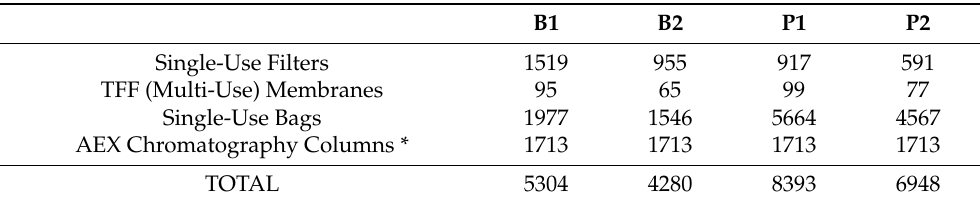
Table 11. Contribution of each type of consumable to the annual cost of consumables, in thousands of dollars. B1 B2 P1 P2 Single-Use